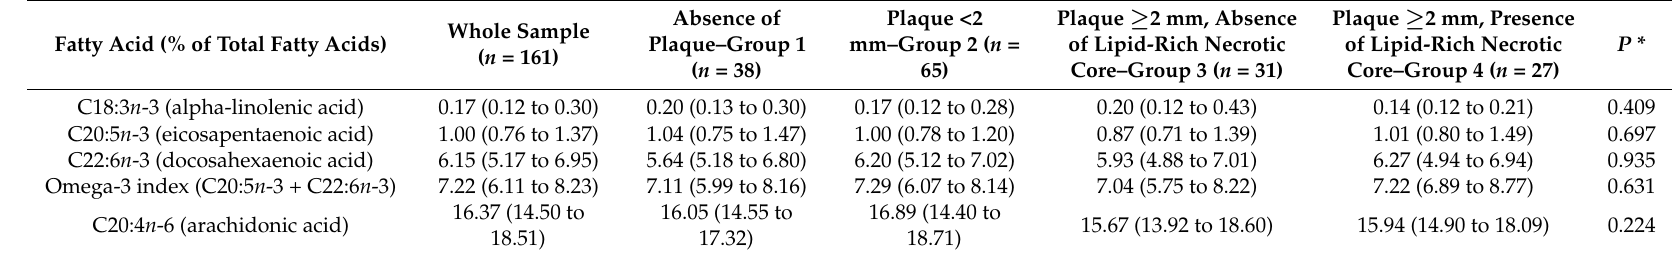
Table 3. Red blood cell proportions of selected fatty acids.